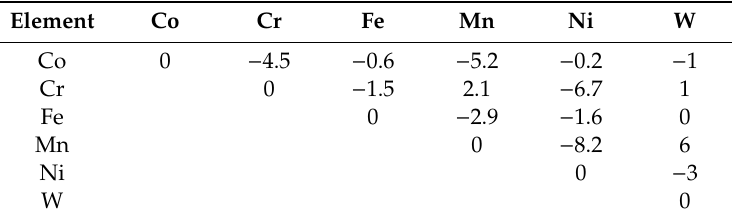
Table 3. Table showing the mixing enthalpy of binary pairs in WHHEA calculated by Miedema’s approach